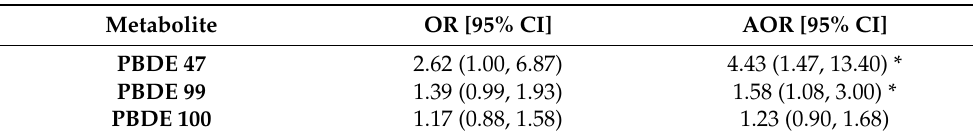
Table 5. PBDE concentrations and high antenatal depression risk among. African American pregnant women (cutoff ≥ 10).